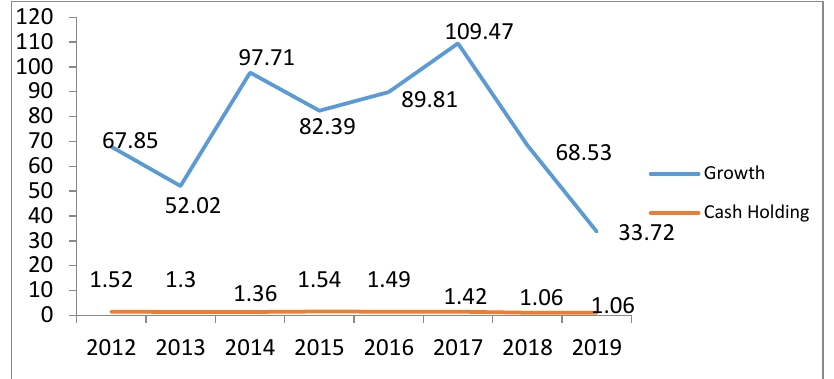
Figure 1. Diagram between Growth Opportunity and Cash